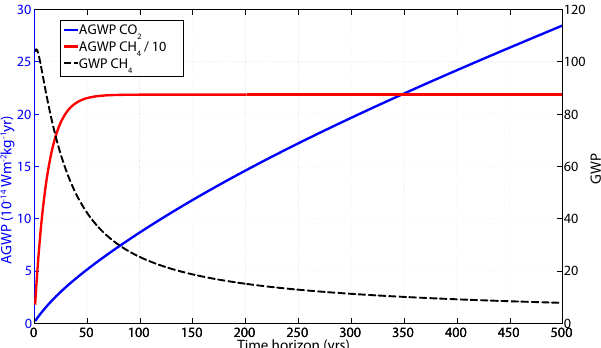
Fig. 6. The GWP CH fected by AGWP for both CH 4 and CO 2 with changing time hori-